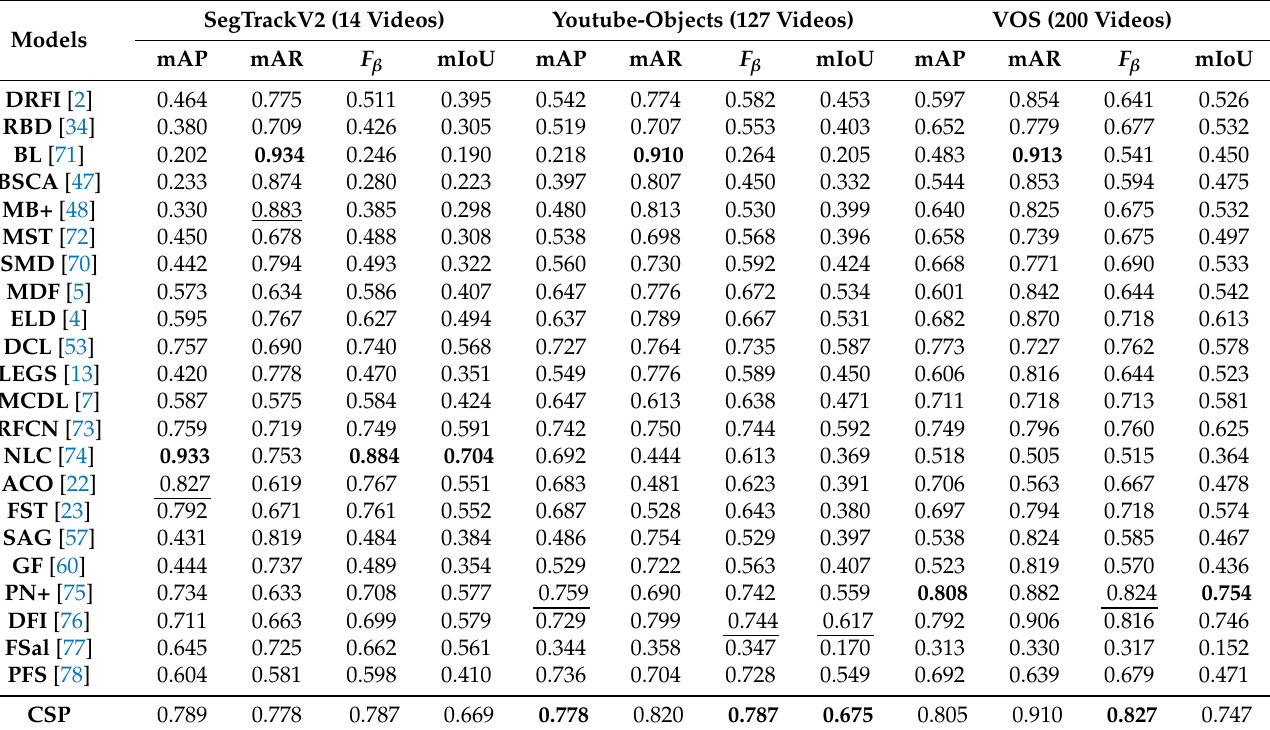
Table 2. Performances of our approach and 22 models. Bold and underline indicate the 1st and 2nd performance in each